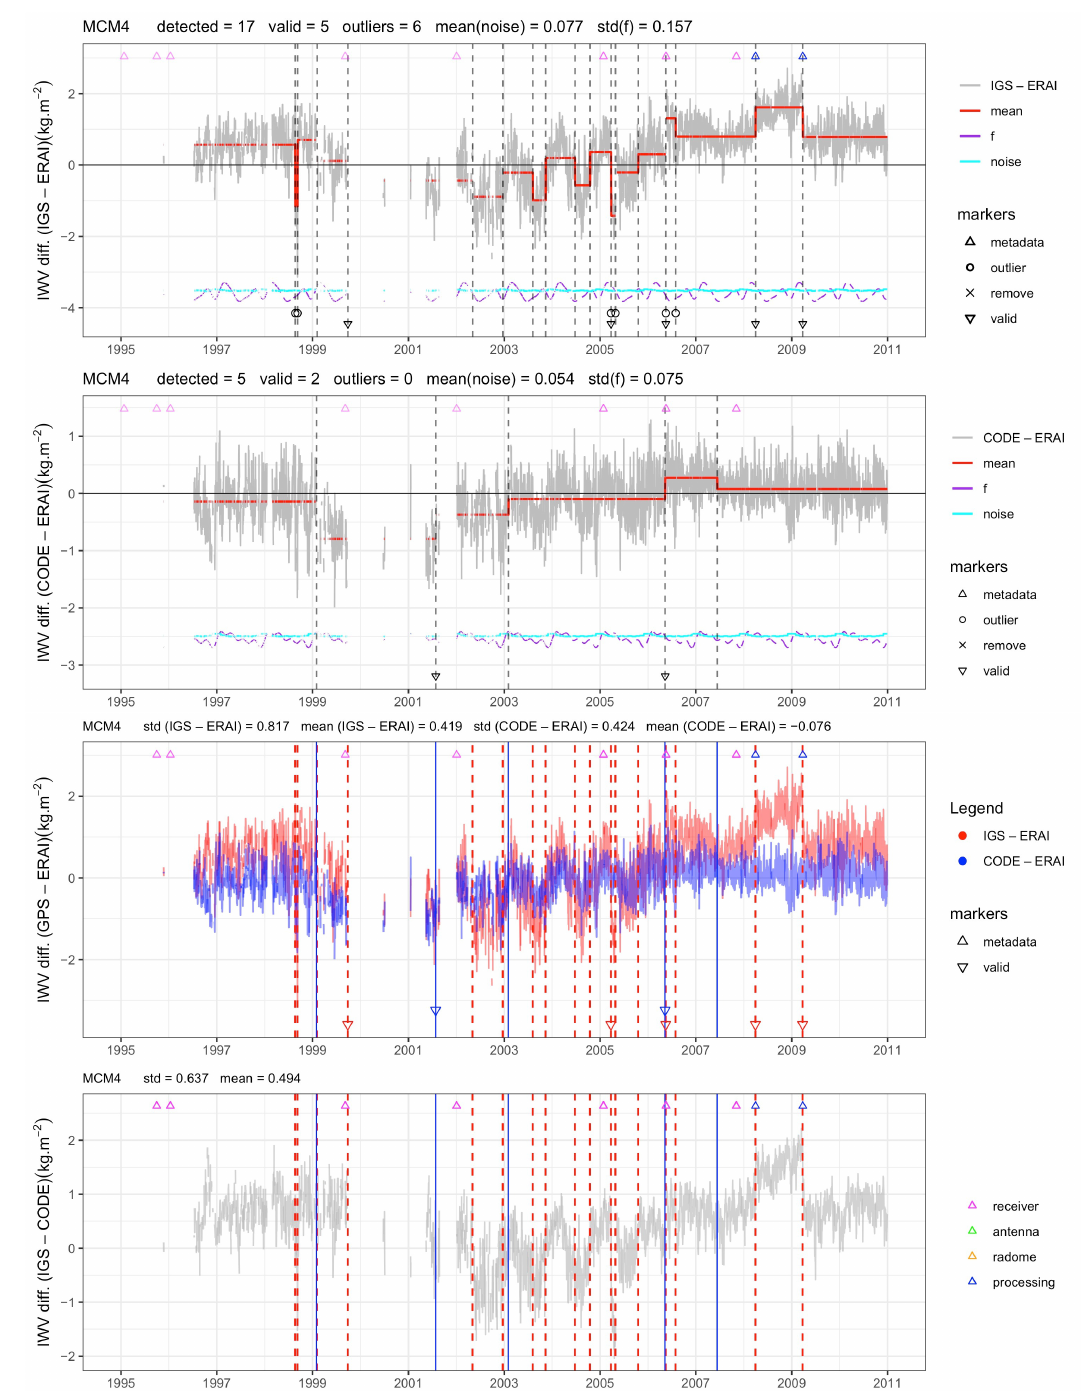
Figure 4. Time series of IWV differences at station MCM4 (McMurdo, Ross Island, Antarctica). The two top plots show the results for IGS-ERAI and CODE-ERAI, with segmentation results superposed (the red line shows the weighted mean as estimated by the segmentation method, where the black dashed lines indicate the change-point positions, the cyan line is the estimated monthly mean variance, and the purple line is the estimated functional modeling the periodic bias). The validated change-points are indicated by a marker at the lower end of the black dashed line. The 3rd plot from the top shows the two IWV difference series and detected change-points for clarity of the comparison. The lower plot shows the difference, IGS-CODE, with change-points superposed. In all plots, the markers at the top indicate the equipment changes. The color code is given in the lower plot. The processing changes apply only to